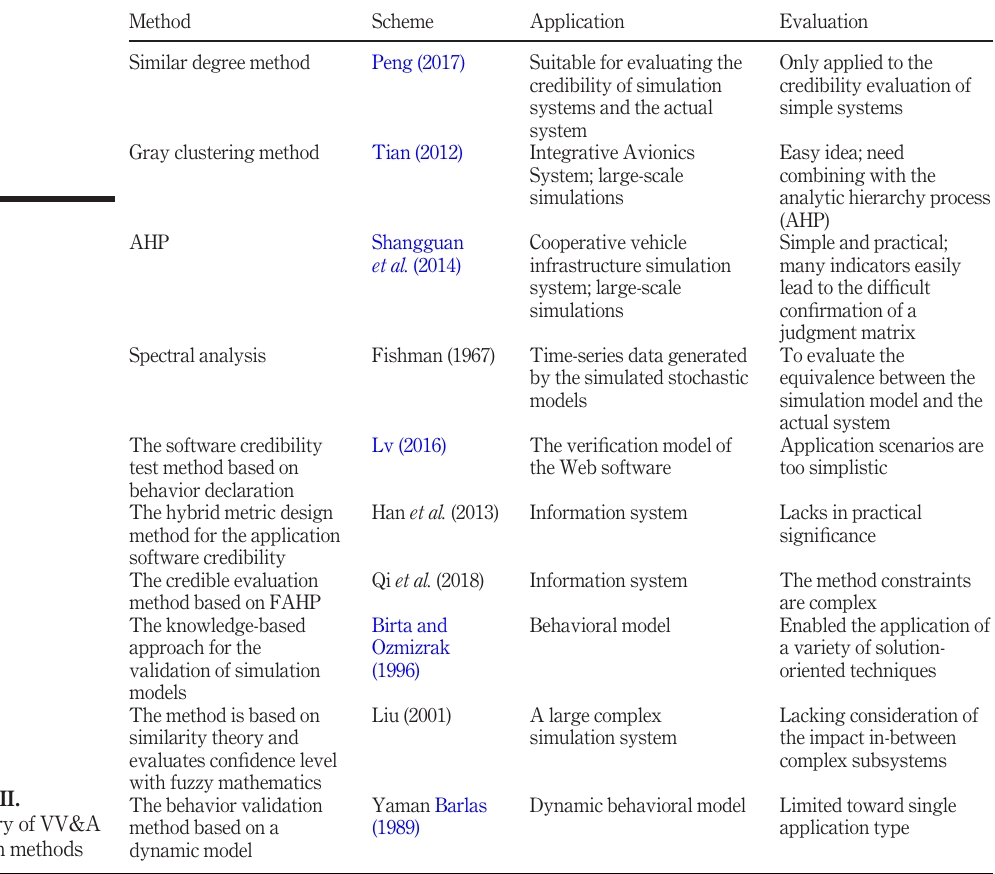
Table III. Summary of VV&A based on